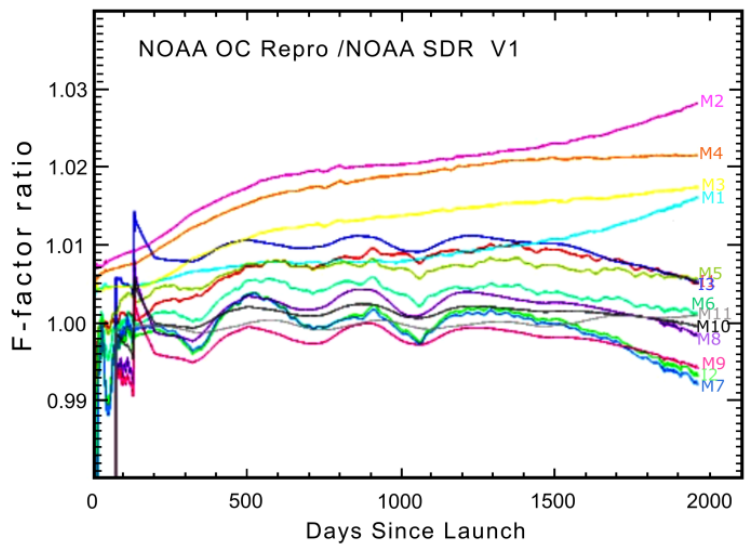
Figure 12. F-factor differences between V1 and OC. M1-M4 bands show long-term calibration differences resulting from lunar-based OC calibration.